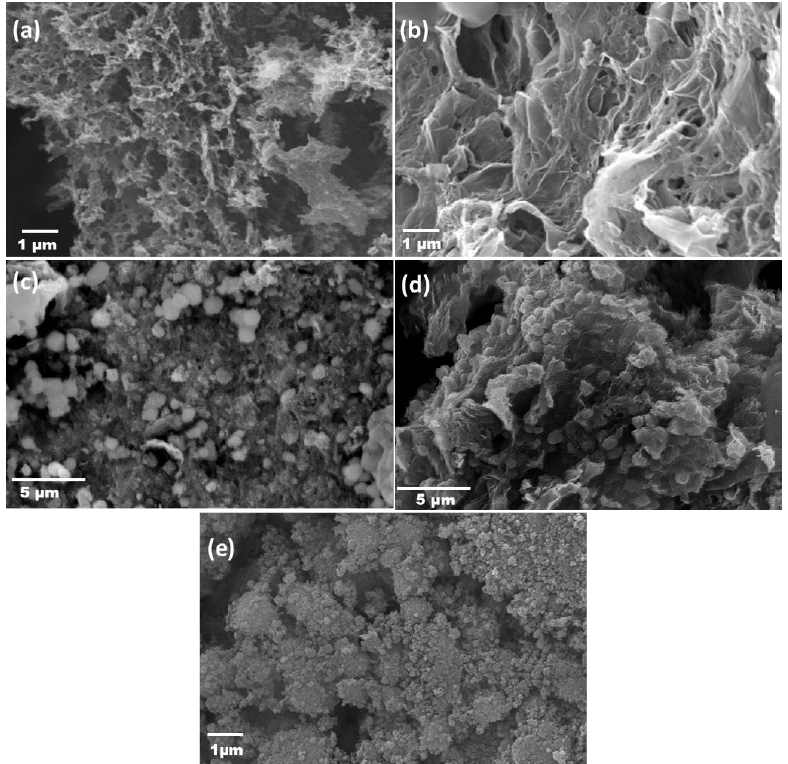
Figure 3. SEM images of ( a ) N-rGO aerogel, ( b ) N,S-rGO aerogel, ( c ) Mn 3 O 4 /N-rGO aerogel, ( d ) Mn 3 O 4 /N,S-rGO aerogel, and ( e ) pristine Mn 3 O 4 .